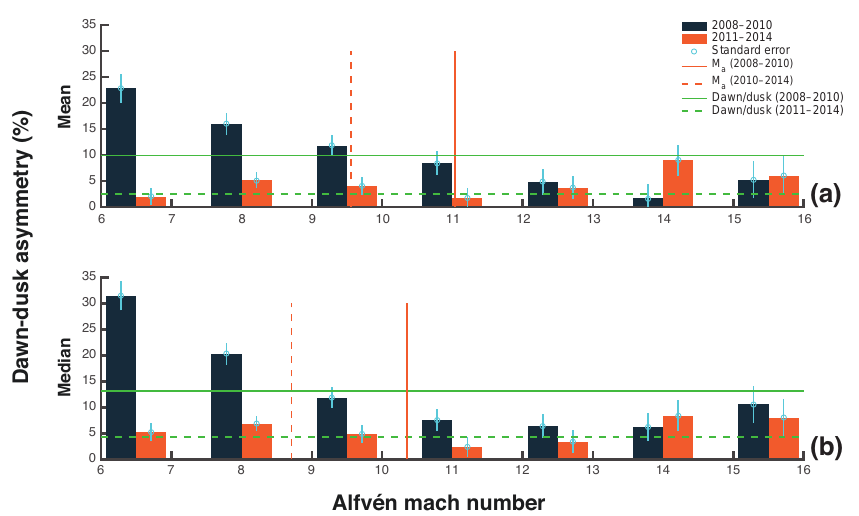
Figure 6. Dawn–dusk asymmetry of normalised ion number density in the dayside magnetosheath as a function of Alfvén Mach number. Panels (a) and (b) show the asymmetry calculated using mean and median averages, respectively. Grey and orange bars represent the asym- metry calculated for two separate time intervals of 2008 through 2010 and 2011 through 2014. In each panel, the vertical orange lines indicate the mean and median values of Alfvén Mach number whereas the horizontal solid and dashed green lines show the mean and median asym- metries for each of the two time intervals, respectively. Each error bar corresponds to the maximum variation of the dawn/dusk asymmetry based on the standard error about the